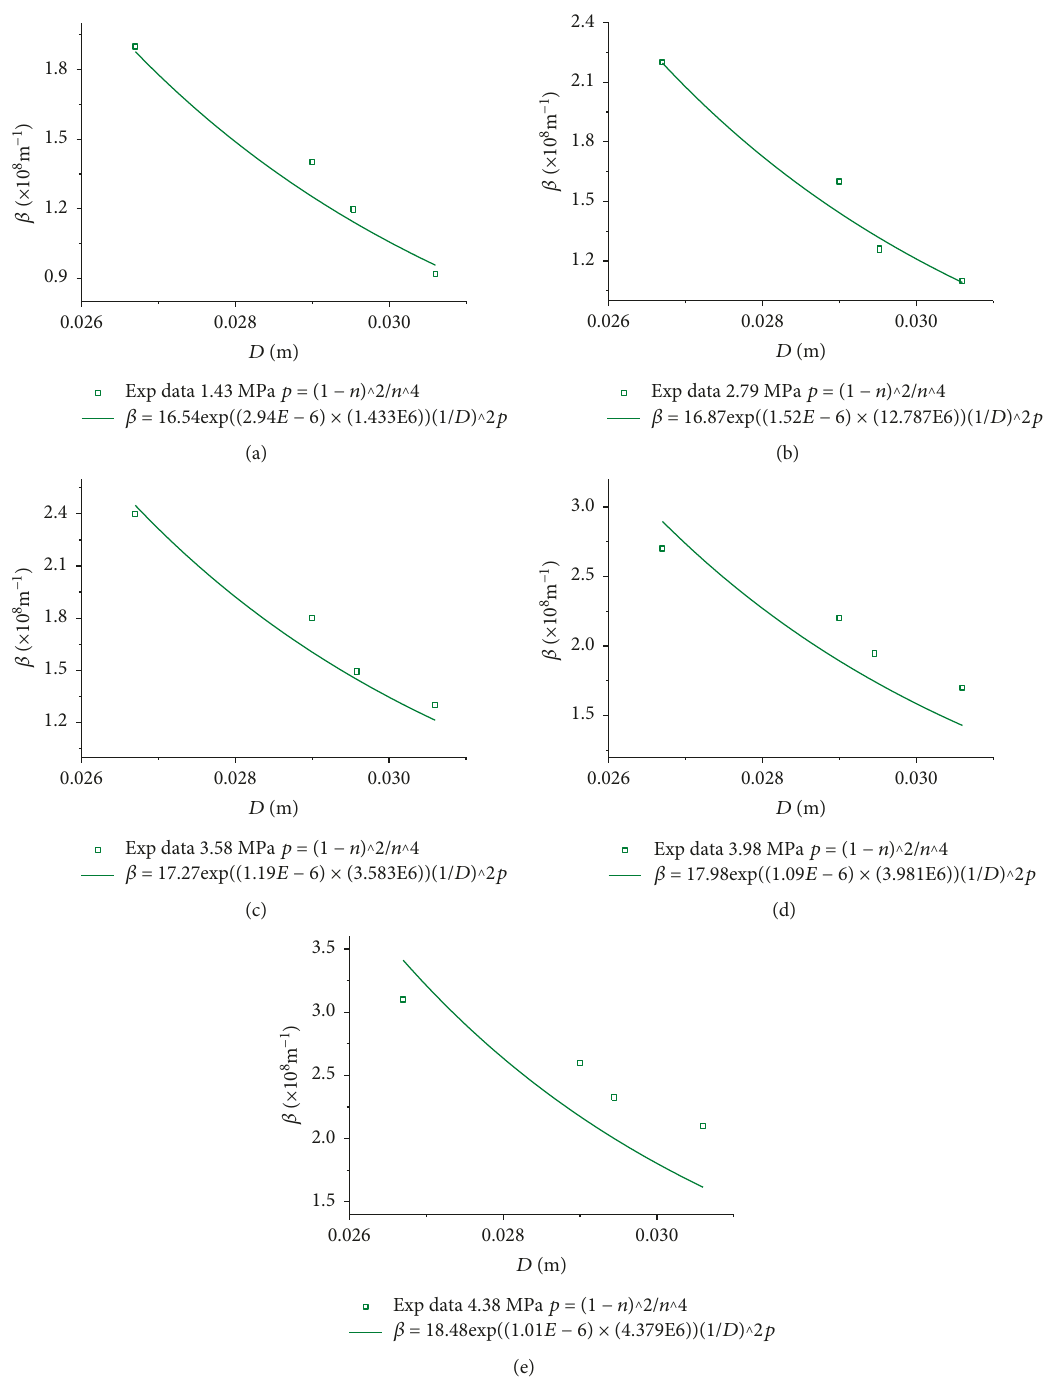
Figure 9: Inertial resistance β characteristic with the in fl uence of particle size and initial porosity under di ff erent